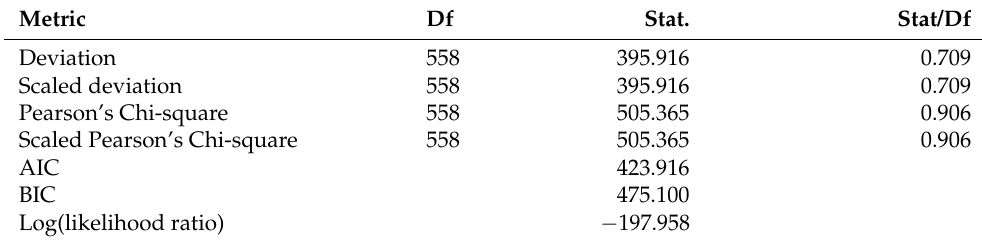
Table 3. Metrics for the ordered logit model presented in Section